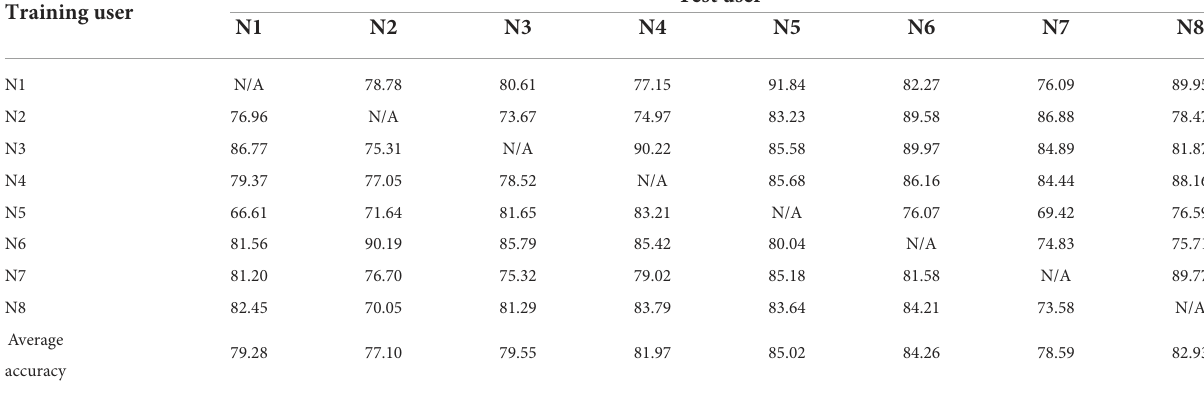
TABLE 6 Experimental results for user-independent CCA-without-ADR framework (the sEMG data of all test users were reduced randomly by two channels). Training user